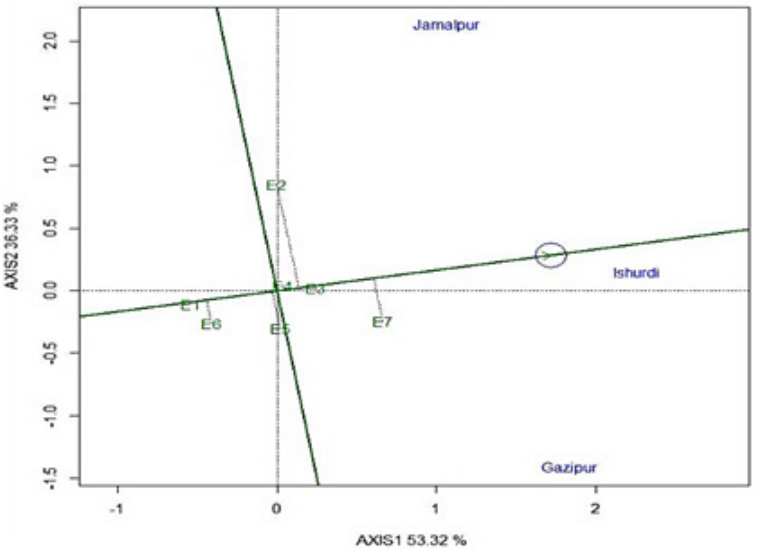
Figure 3: Mean performance and stability of seven genotypes and specific genotype by environment interactions